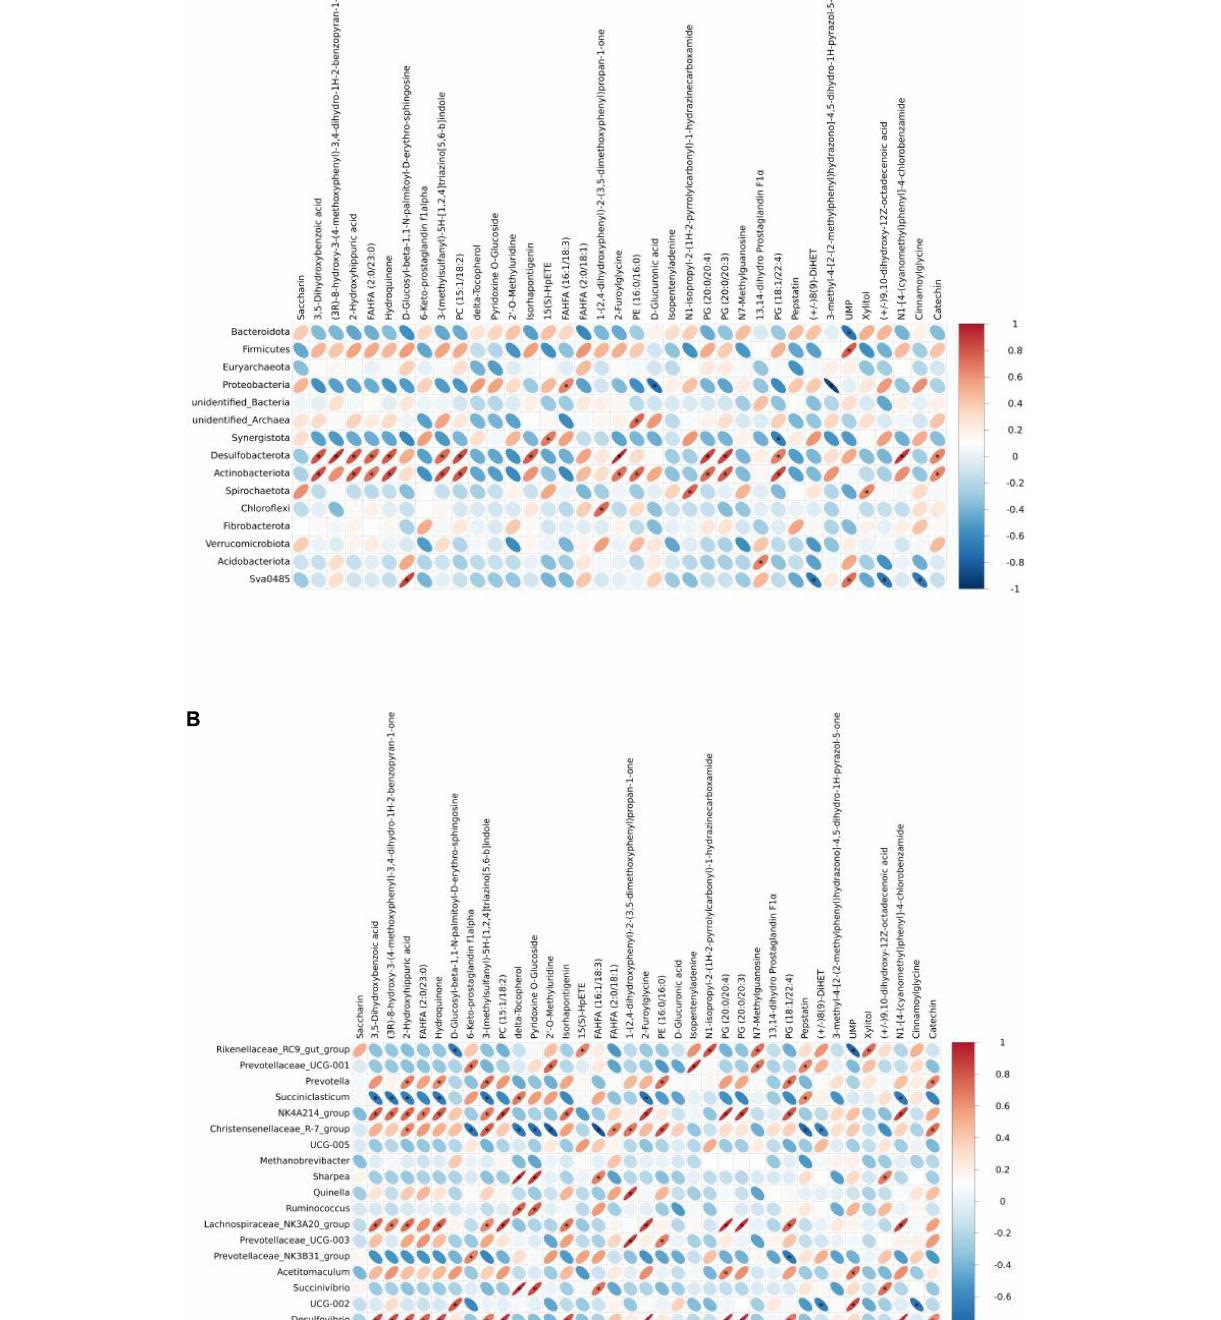
calves, and thus improves production performance. Studies have shown that Ruminococcus , as a producer of carbohydrate-active enzymes (Rosewarne Carly et al., 2012), can decompose dietary fiber and improve the decomposition of hemicellulose and